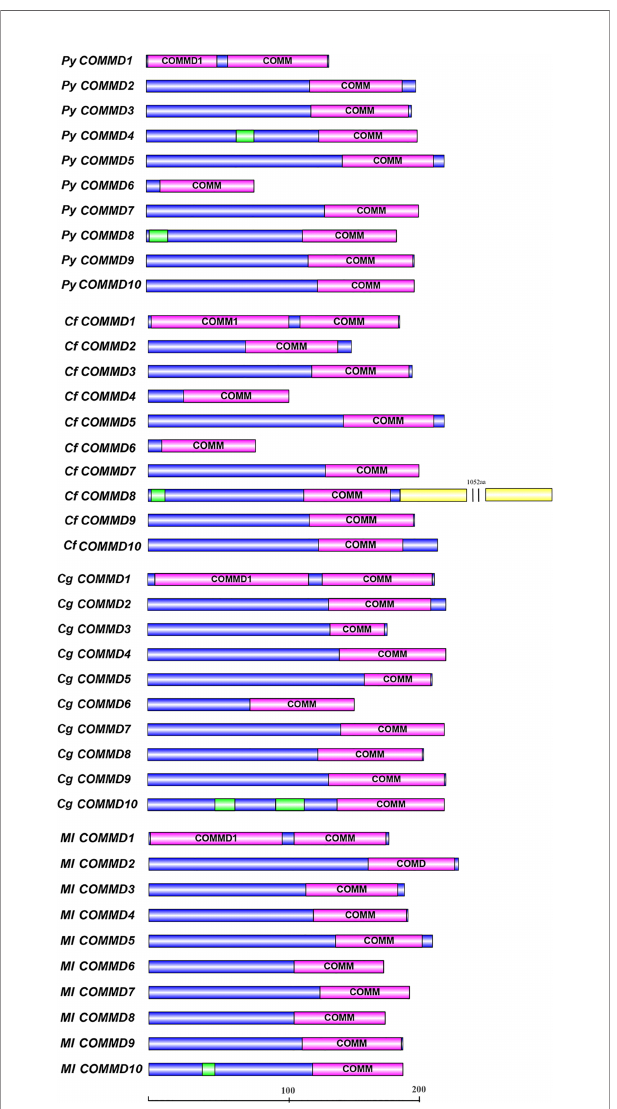
FIGURE 1 | The structure of COMMD proteins in four bivalves. The purple boxes indicate the conserved COMM domains. The green boxes indicate the low-complexity regions, and the yellow boxes indicate the Glyco_hydro_15 Pfam